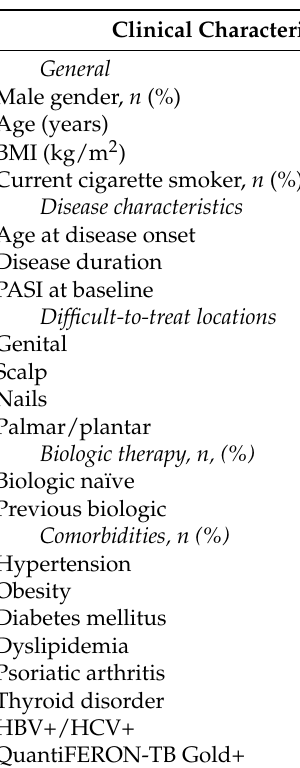
Table 1. Baseline clinical characteristics of psoriasis